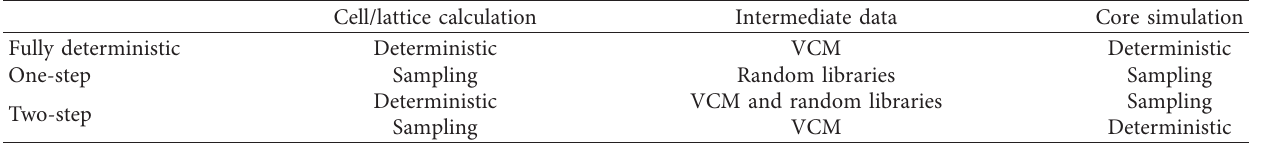
Figure 9: Correlation coefficient matrix of the two-group homogenized cross sections of the unrodded lattice from (a) Case 6, (b) Case 10, (c) Case 11, and (d) Case 12. Table 2: Uncertainty propagation methodologies in reactor full-core simulations